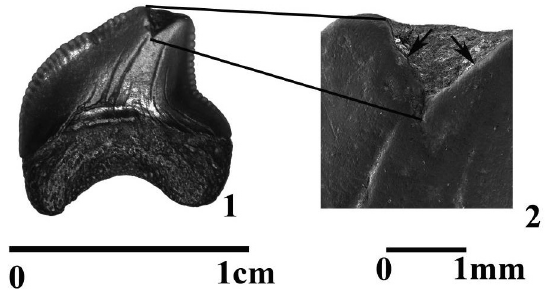
Figure 8. Squalicorax kaupi tooth in labial view. 1 , Labial feeding-related damage on the tooth cusp apex. (Type A damage); 2 , 70X SEM close-up of cusp apex. Note rounded edges adjacent to missing enameloid and exposure of osteodentine and orthodentine. Scale bar: 1 = 1.0 cm; 2 = 1.0